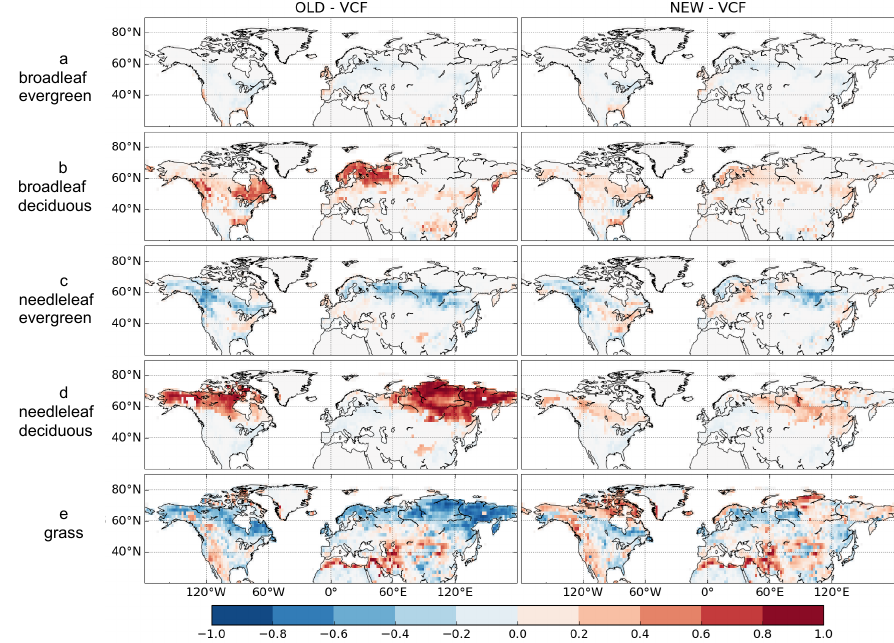
Figure 8. Difference in fractional cover of PFT groups between the model (OLD and NEW) and observation-derived PFT map (VCF). Similar map for the difference between model and ESA/GLC is shown in Fig.